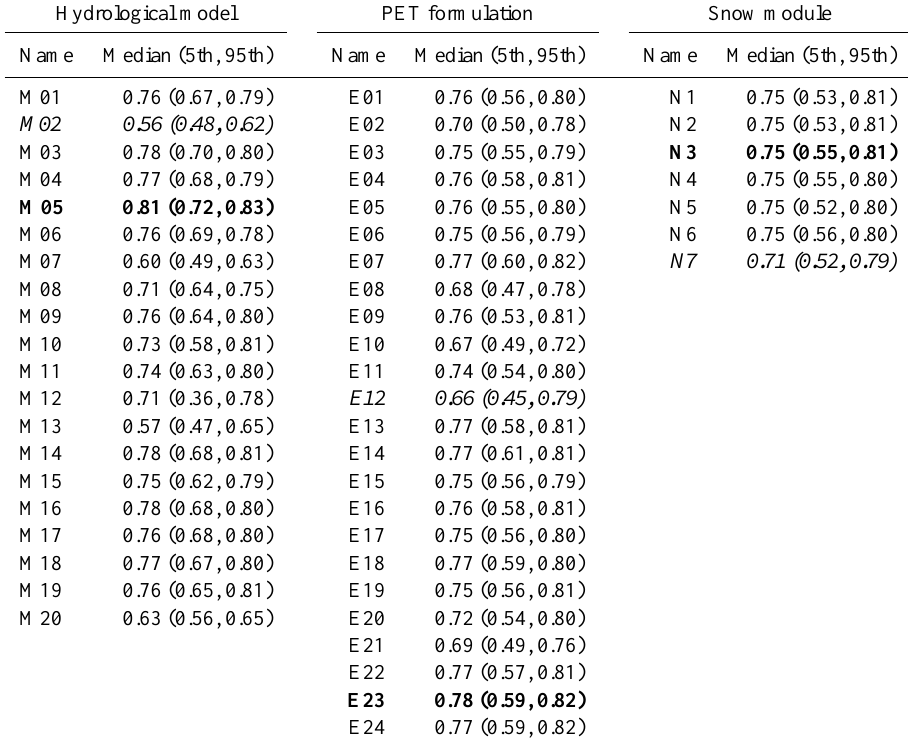
Table 4. Characteristics of the calibration performance (NSE sqrt ) pooled by hydrological models, PET formulations and snow modules. Bold corresponds to the best performing options, when italic is the worst